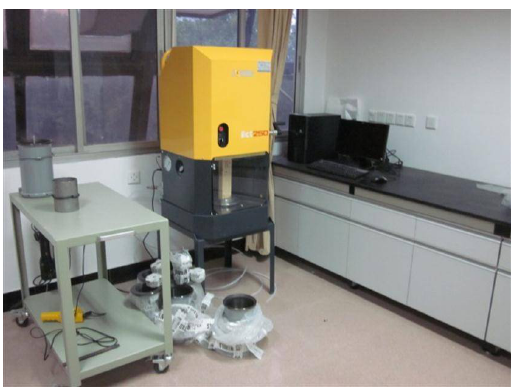
Figure 4. Diagram of the Superpave gyratory compactor used in this paper.